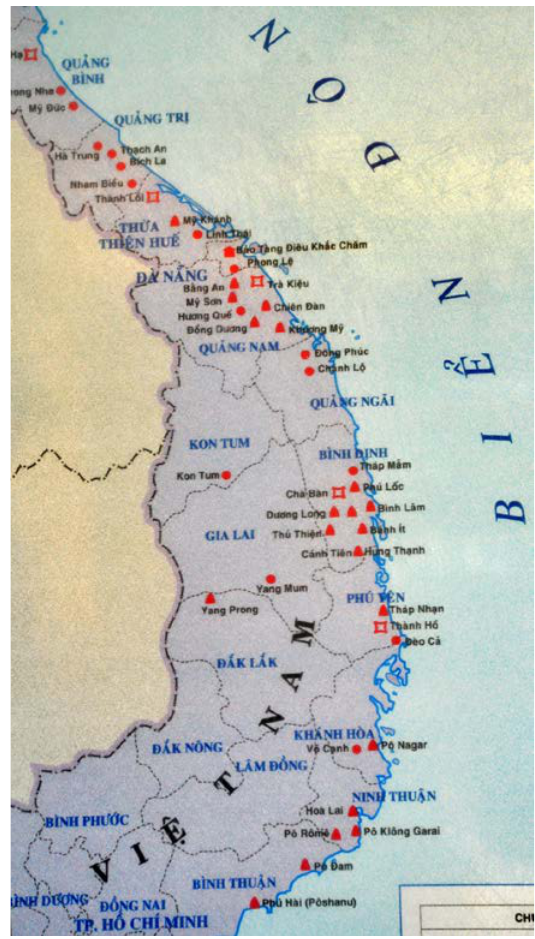
Figure 1. The location of the Cham Towers surveyed in